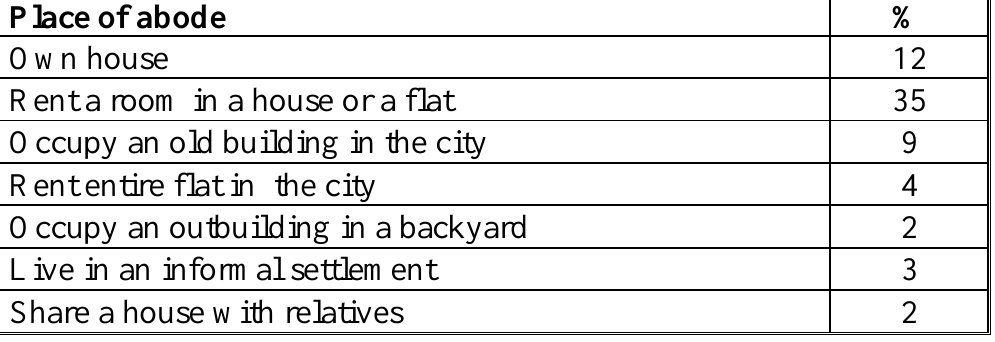
Table 1: Place of abode Place of abode % Own house 12 Rent a room in a house or a flat 35 Occupy an old building in the city 9 Rent entire flat in the city 4 Occupy an outbuilding in a backyard 2 Live in an informal settlement 3 Share a house with relatives